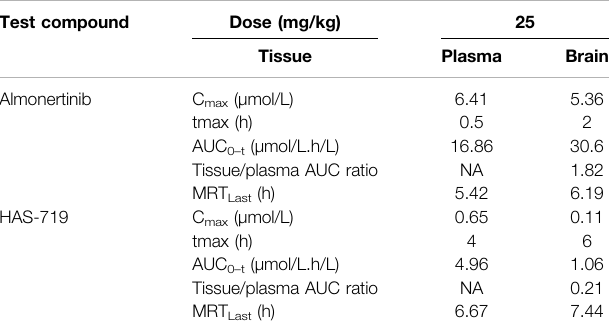
TABLE 1 | Pharmacokinetics of almonertinib and HAS-719 in plasma and brain following oral administration of almonertinib at 25 mg/kg to female BALB/c nude mice bearing PC9-LUC tumor xenografts.